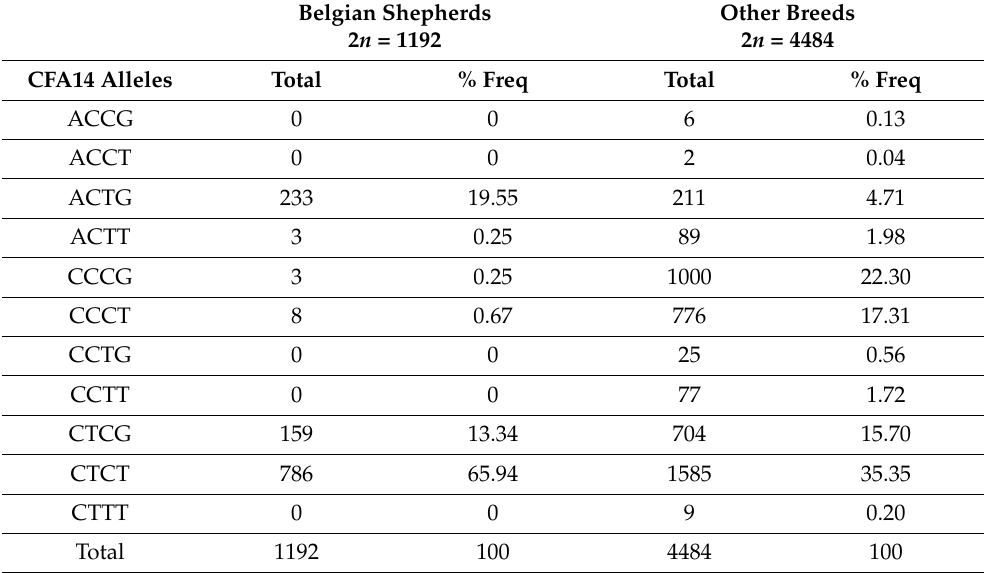
Table 2. Frequency of canine chromosome 14 (CFA14) 4-SNP haplotypes associated with idiopathic epilepsy risk in the Belgian shepherd compared to other breeds. Belgian Shepherds Other 2 n = 1192